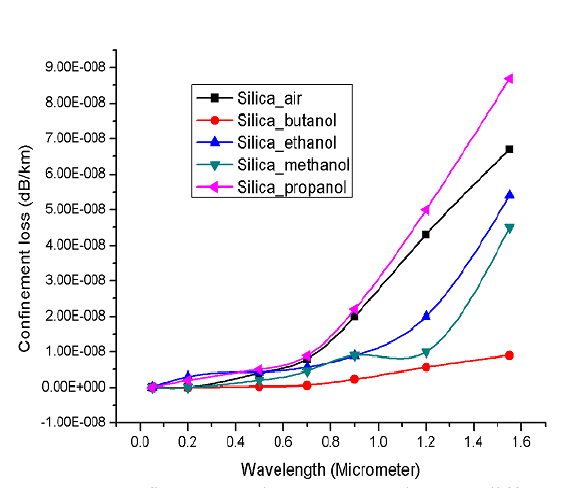
Figure 3: Confinement loss reported at different wavelengths Effective mode area is inversely proportional to the